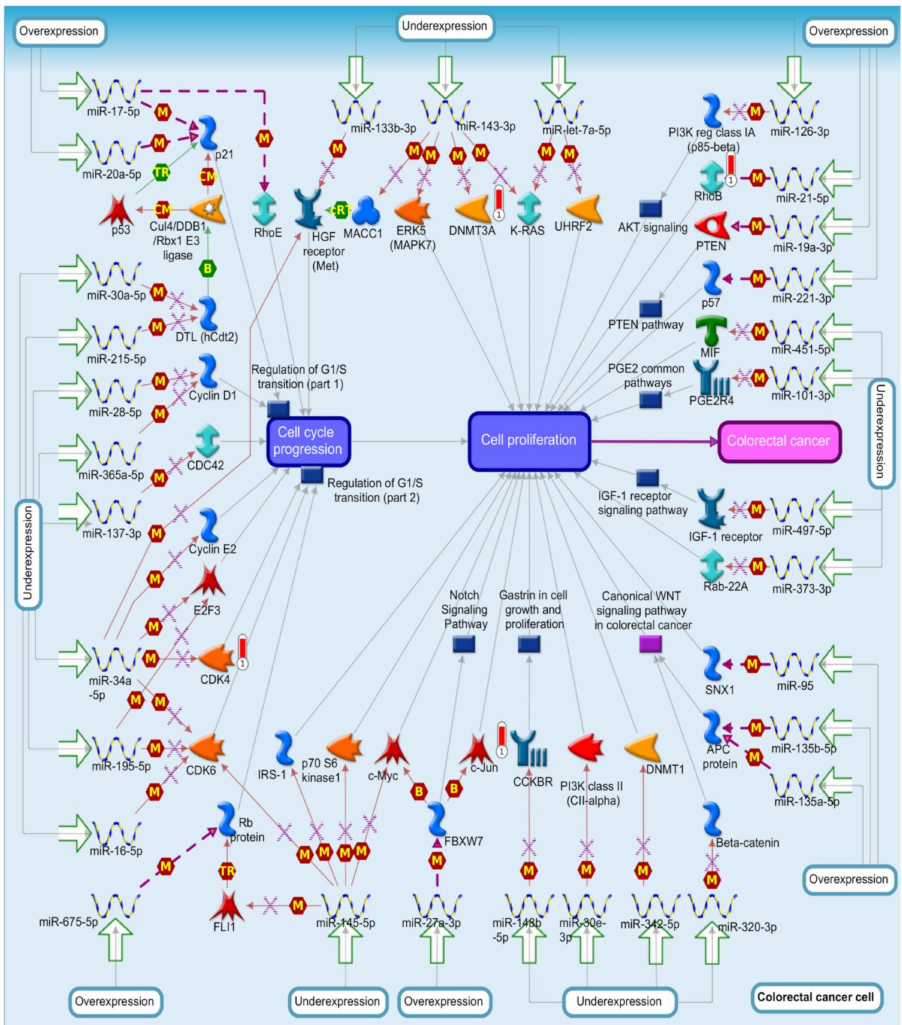
Figure 8. MetaCore pathway analysis of fatty-acid binding protein 6 ( FABP6 ) co-expressed differentially expressed genes (DEGs) in colorectal cancer patient databases. FABP6 co-expressed genes in colorectal cancer from TCGA databases were acquired and identified by Venn diagram analysis. These 243 genes were further exported to the MetaCore pathway analysis tool to identify gene networks and signaling pathways. The “role of microRNAs in cell proliferation in CRC” was identified as one of the top three enriched pathways in the formation of CRC. The network suggested that the differential expression of microRNAs will lead to colorectal cancer cell progression. B, binding; CM, covalent modification; + p , phosphorylation; T, transformation; Tn, transport; Z, catalysis; TR, transcription regulation; IE, influence on expression; GR, group relation; CS, complex subunit. A green arrow represents (positive) activation of the process. A red arrow represents (negative) inhibition of the process. A gray arrow represents an unspecified